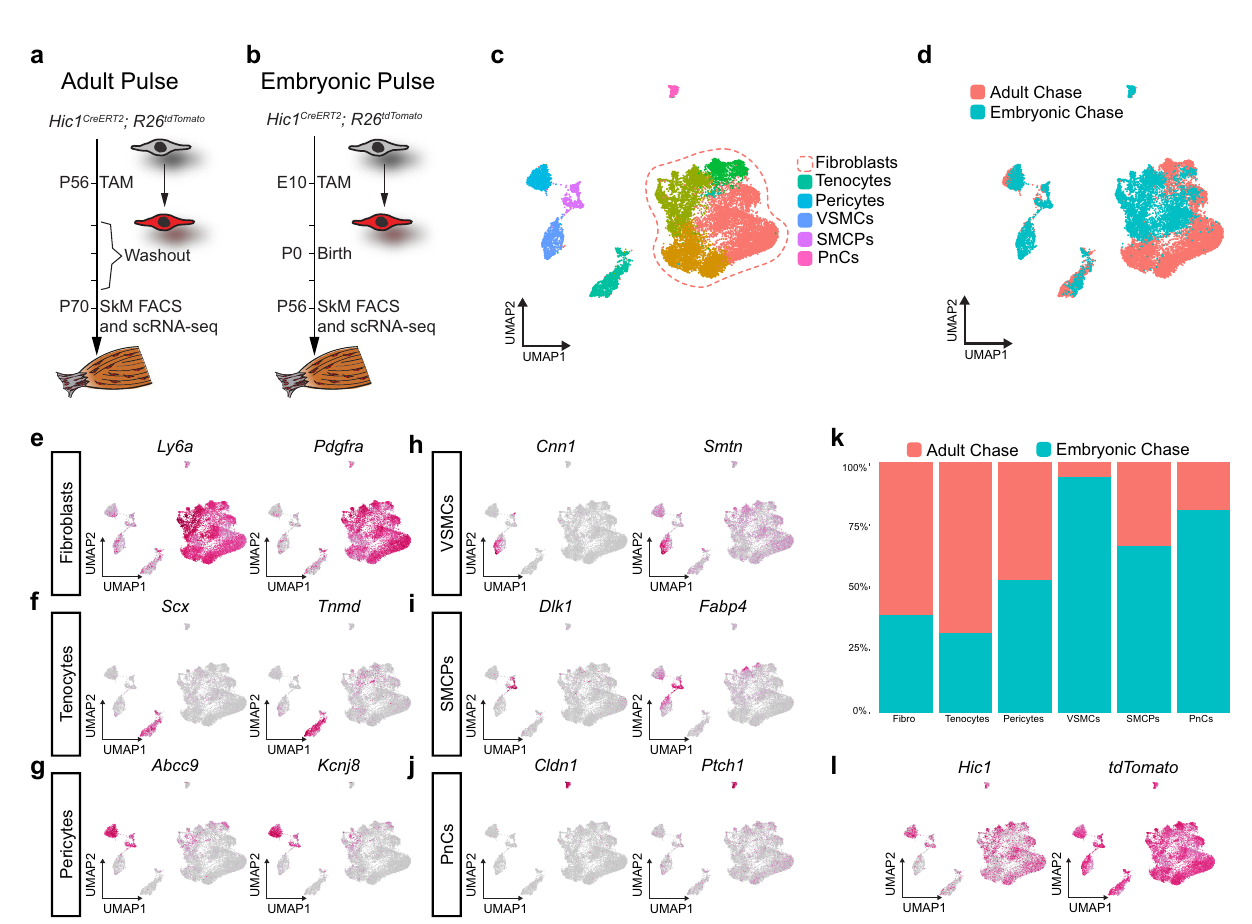
progenitors ( h ); and perineural cells ( i ). White arrowheads highlight cells of interest. White-dotted boxes highlight regions that are magni fi ed in larger panels. n =3 biologically independent mice for panels a – i . Scale bars, 50 µ m. j Violin plots of selecttranscripts. k Schematicof thediverse mesenchymallimb lineages captured by labelling at E10 from development into adulthood.BMSPs, bone marrow stromal progenitors; DFs, dermal fi broblasts; EnCs, endoneural cells; Fibro, fi broblasts; PDFs, papillary dermal fi broblasts; PnCs, perineural cells; RDFs, reticular dermal fi broblasts; SMCPs, smooth muscle cell progeni- tors; vSMCs; vascular smooth muscle cells; WAT, white adipose tissue. Created with BioRender.com.